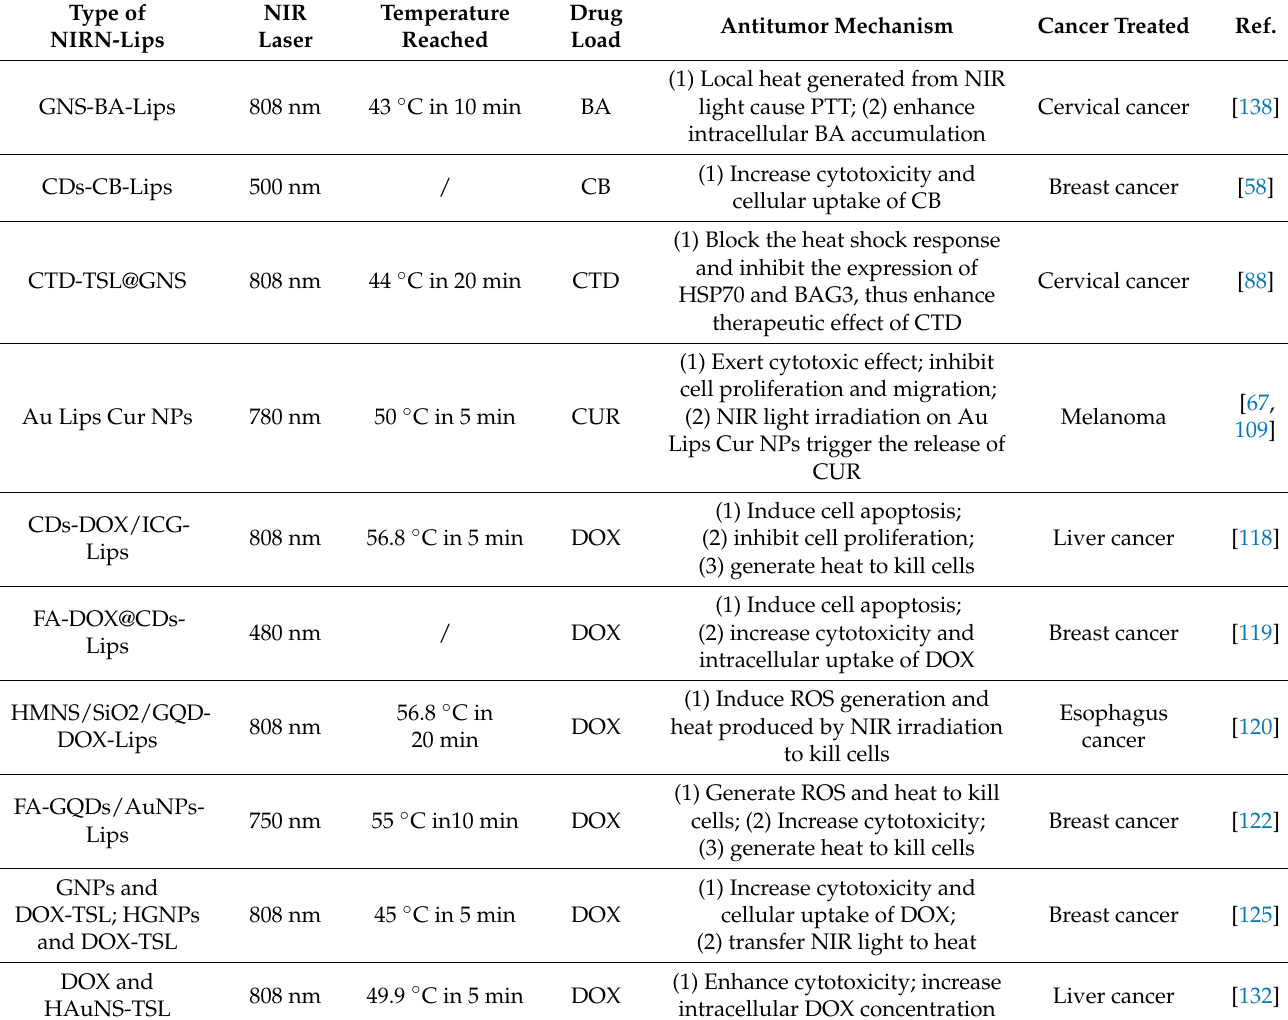
Table 3. Brief summary of the recently developed NIRN-Lips for cancer